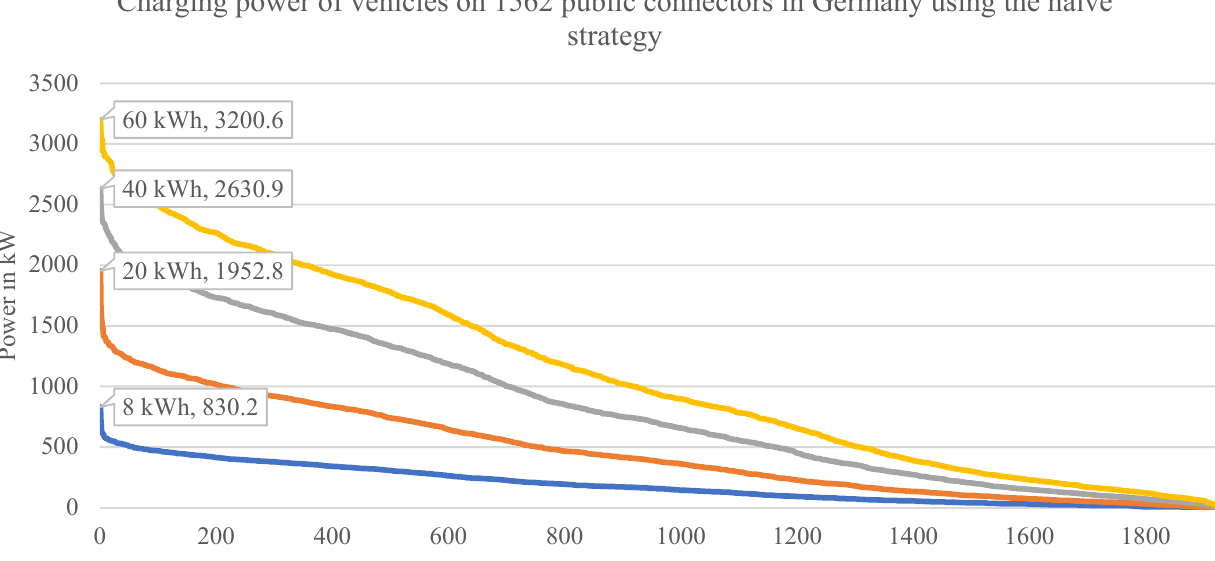
Hour in observed period sorted by power for each line seperately